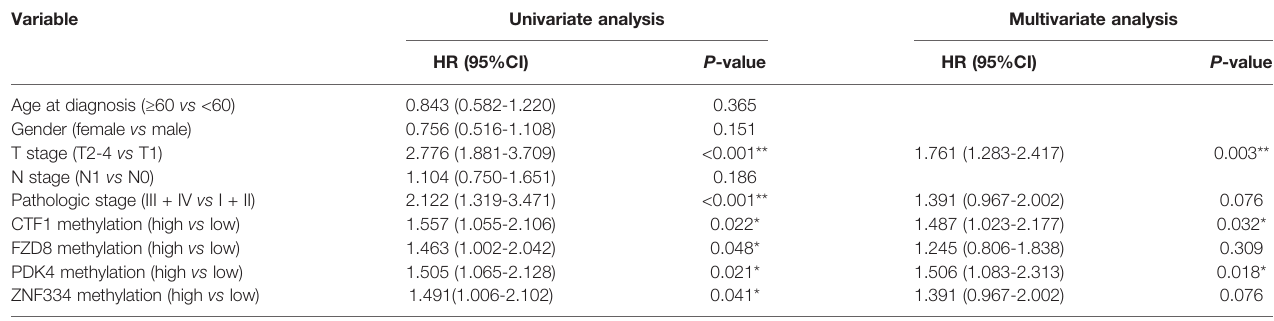
TABLE 2 | Cox regression analyses of association between prognosis-related MeDEGs and clinicopathological characteristics.